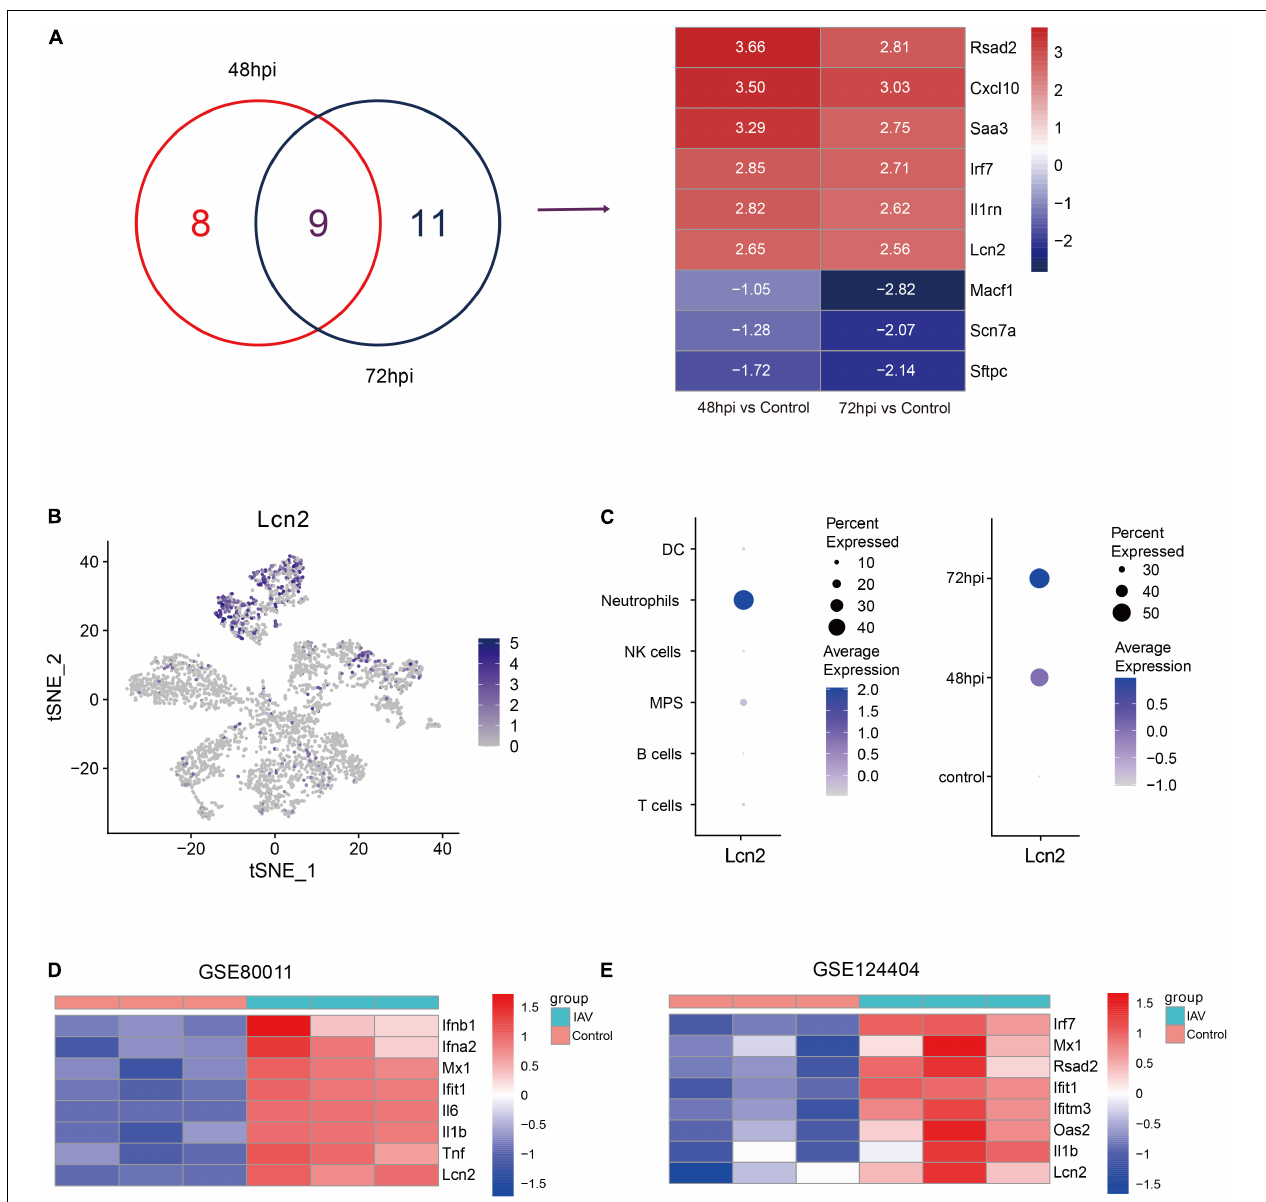
FIGURE 2 | Identification and validation of key genes in IAV infection in public dataset. (A) Venn diagram to indicate 9 shared genes from DEGs and log2 fold change of shared genes (GSE107947). (B) Expression level of LCN2 in immune cells. (C) LCN2 expression level of neutrophils in different groups. (D,E) Validation of LCN2 in IAV